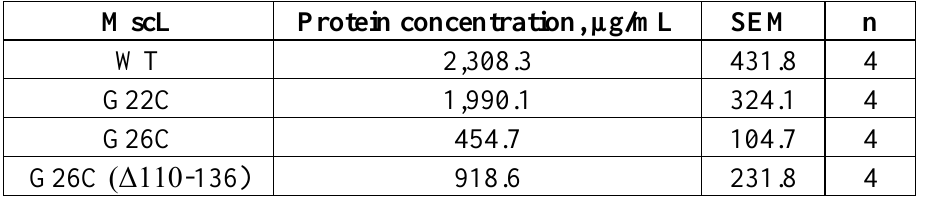
Table 1. Protein yield comparison of MscL